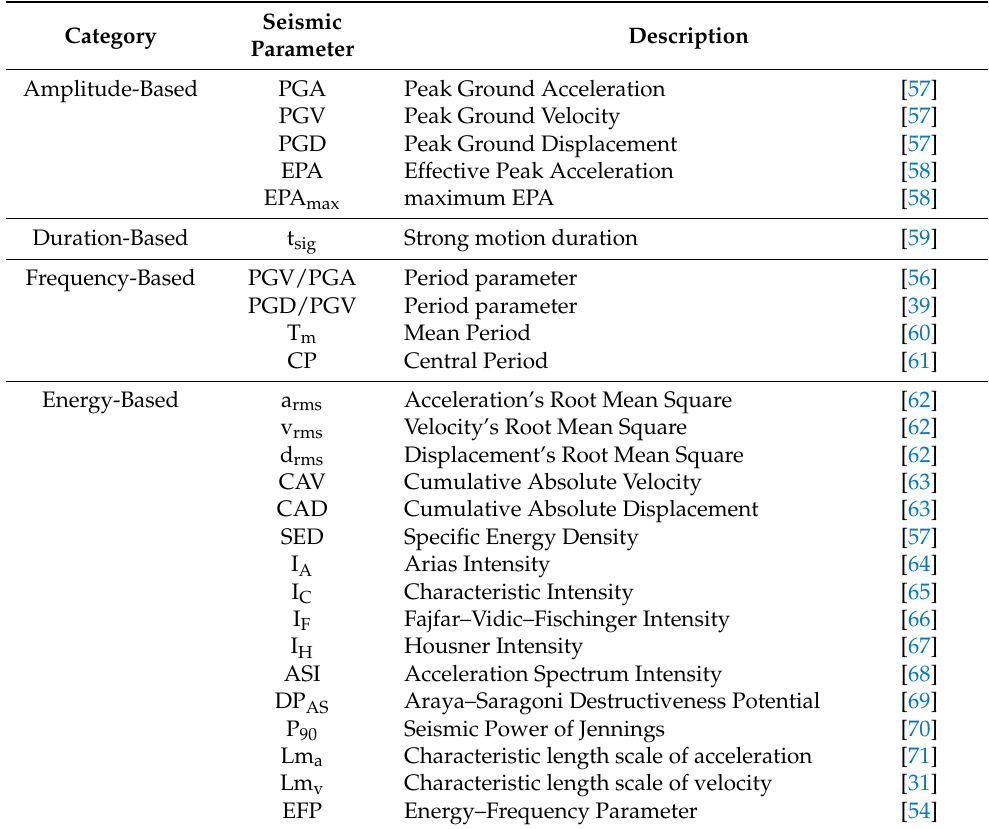
Table 1. Conventional